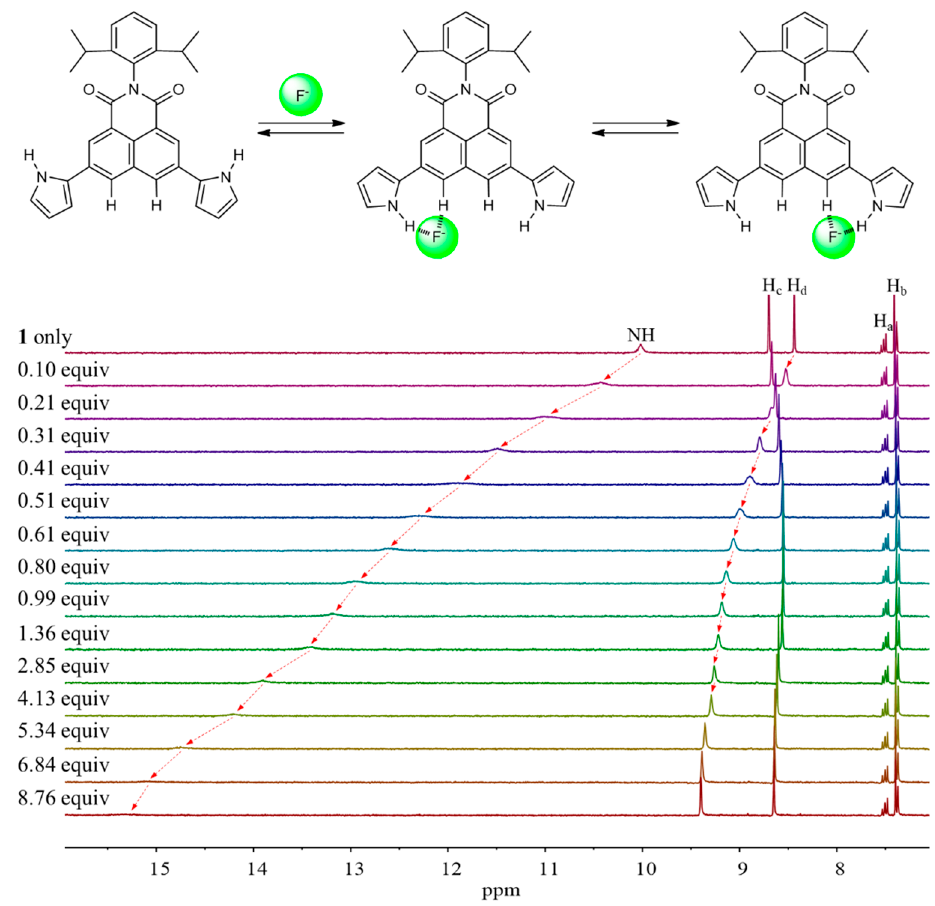
Figure 6. Top: Proposed binding mode of receptor 1 for the fluoride anion. Bottom: Partial 1 H NMR spectra recorded during the titration of receptor 1 (3 mM) with TBAF in CD 3 CN.